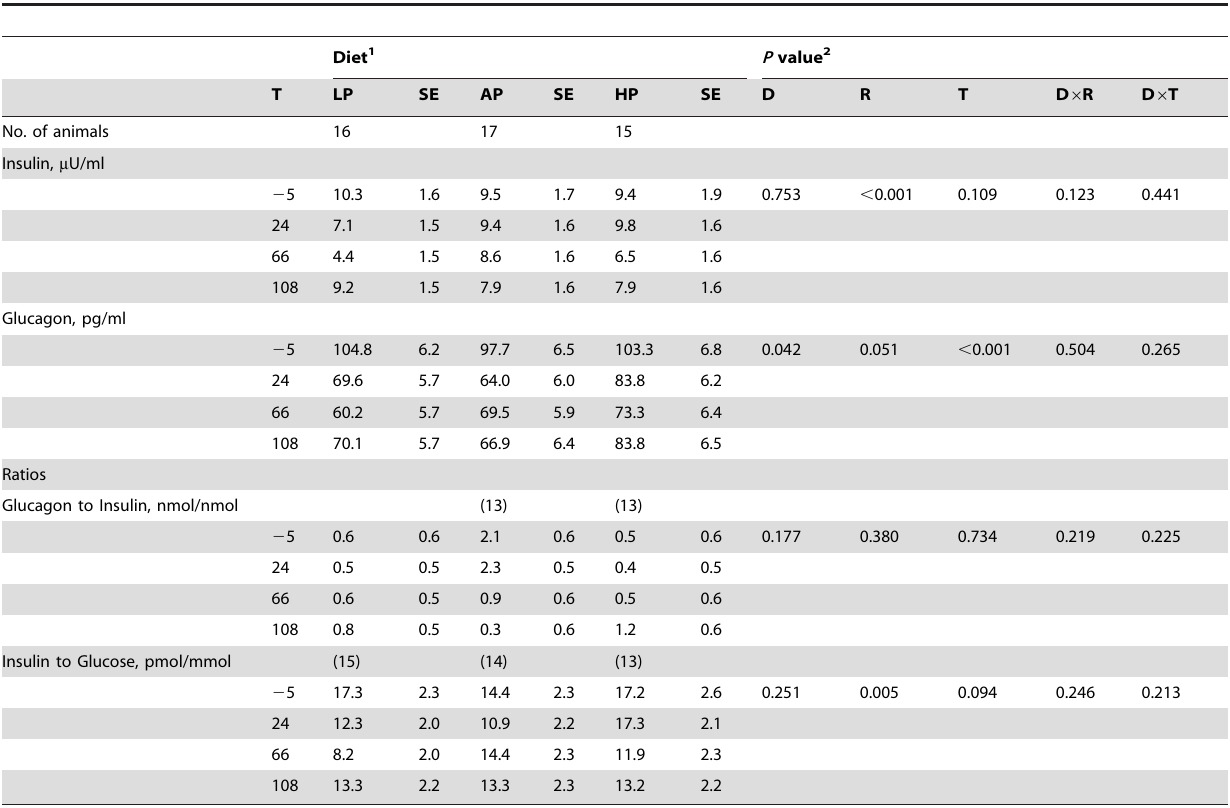
Table 4. Basal plasma insulin and glucagon concentrations as well as insulin ratios of sows at 5 days before and 24, 66 and 108 days after